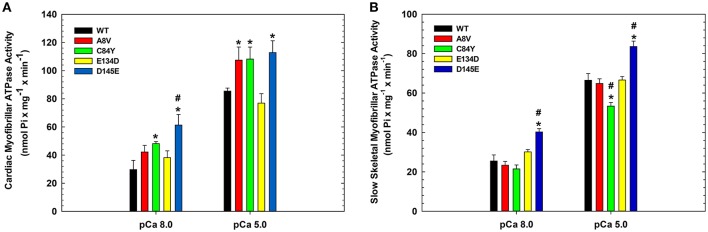
Myofibrillar ATPase activity of (A) porcine cardiac and (B) bovine masseter muscle myofibrils that were depleted of TnC and reconstituted with WT cTnC or cTnC HCM mutants. (*) Indicates significant differences (p < 0.05, Student's t-test) for mutant cTnCs compared to WT in the same muscle type and pCa. (#) Indicates significant differences (p < 0.05, ANOVA/Tukey's HSD) for mutant cTnCs compared to WT in the same muscle type and pCa. ATPase values for these experiments are summarized in Table 2. Data are shown as mean ± S.E.M.